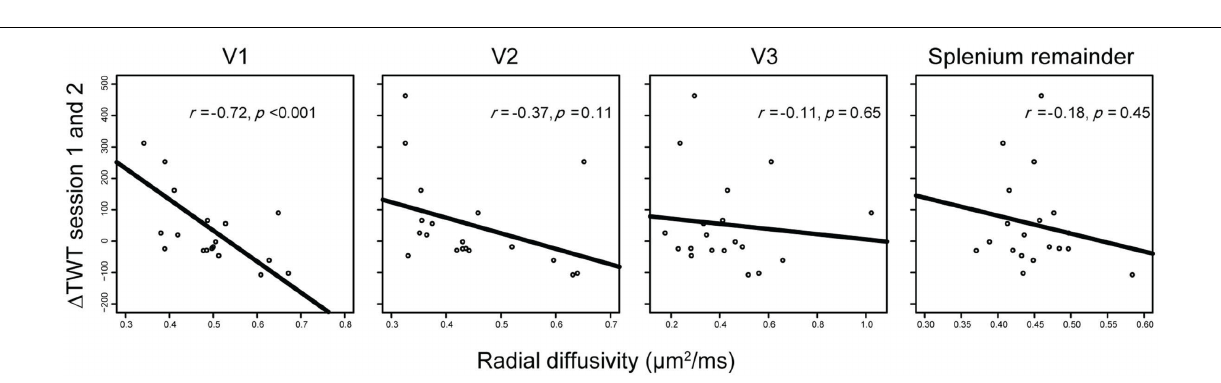
FIGURE 4 | Reliability of the behavioral measures. (A) Analyses show high retest reliabilities for interhemispheric traveling wave time, intrahemispheric traveling wave time and the difference of the two indices ( Δ TWT).